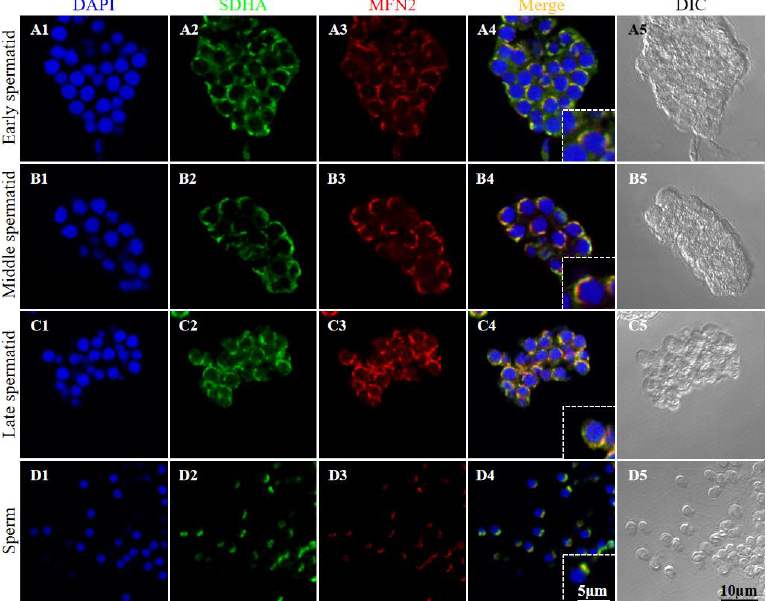
Figure 6. Expression of Pe -MFN2 and its co-localization with succinate dehydrogenase (SDHA) during spermiogenesis in P. esculenta . ( A1 – A5 ) Early spermatid, ( B1 – B5 ) middle spermatid, ( C1 – C5 ) late spermatid, and ( D1 – D5 ) sperm. Blue indicates nuclei stained with DAPI, green indicates SDHA, a mitochondrial marker, and red indicates MFN2. DIC, differential interference contrast imaging.